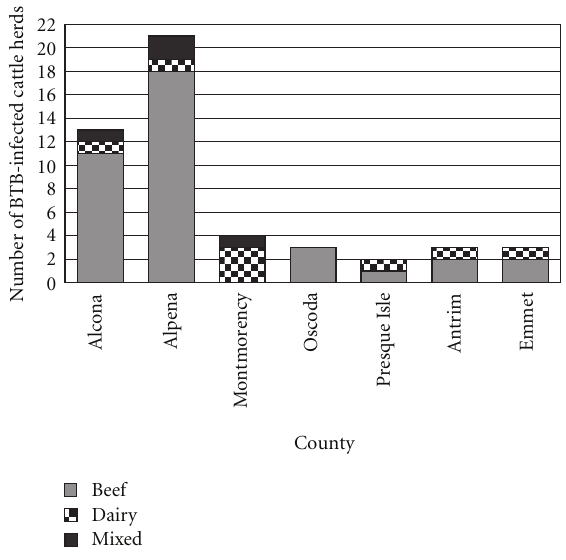
Figure 4: BTB incidence count in Michigan cattle herds by type, 1998–July 2010.